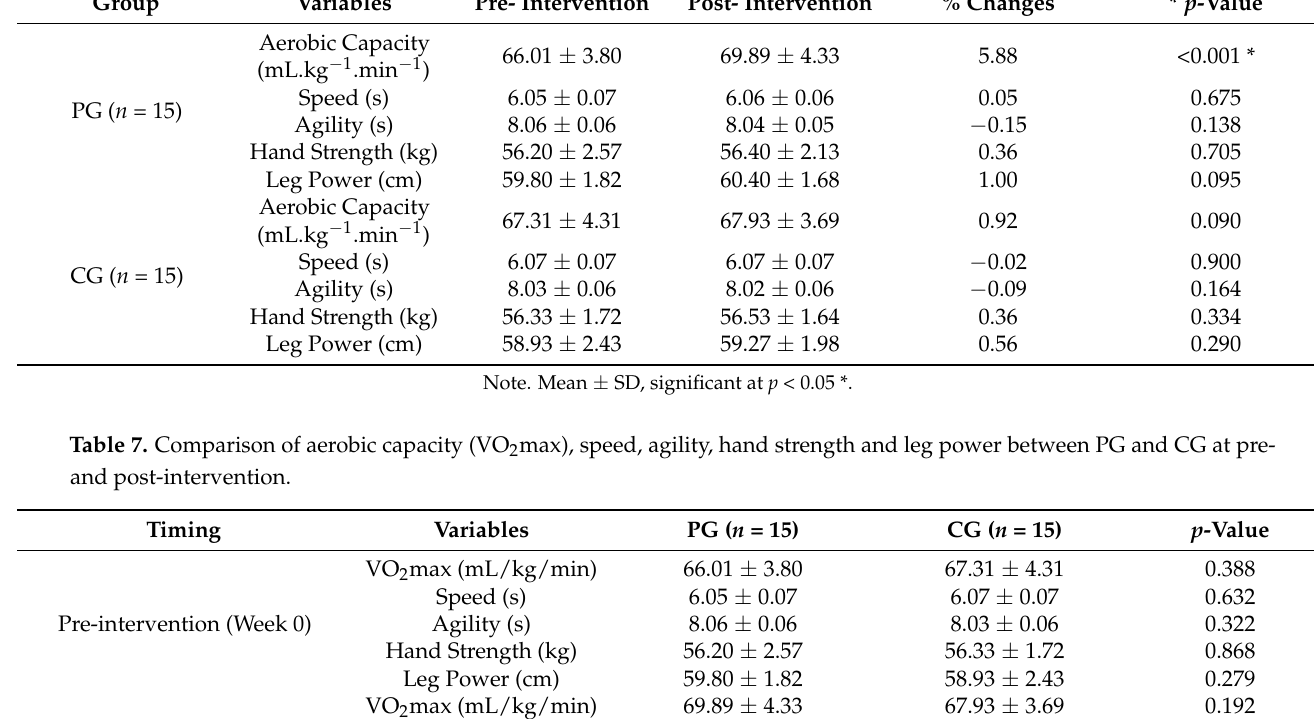
Table 6. Aerobic capacity, speed, agility, hand strength and leg power of PG and CG before and after 6-weeks of intervention. Group